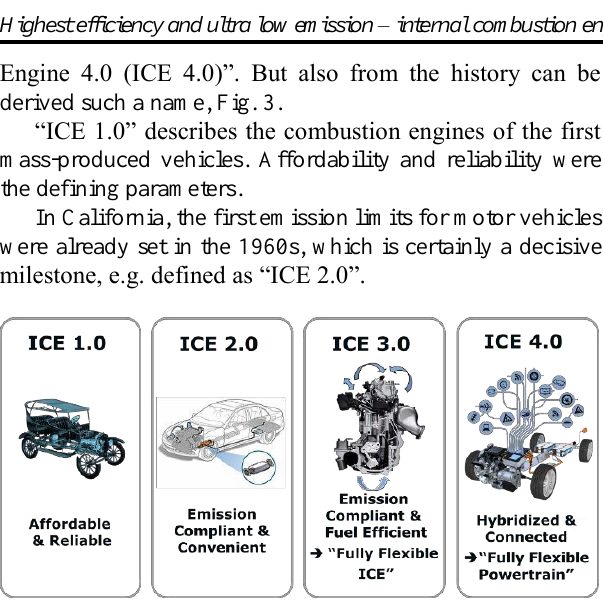
Fig. 3. Generations of ICE based passenger car power- train systems In the following decades, the limit values for pollutant emissions and fleet consumption target values to be proven on the chassis dynamometer were steadily tightened and required significantly increased variability, the "Fully Flex- ible Internal Combustion Engine – here described as “ICE 3.0”.